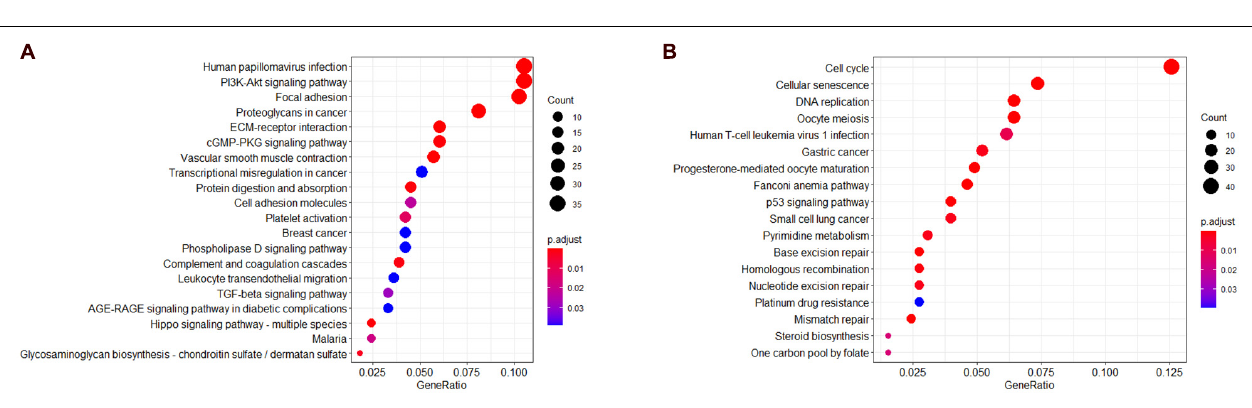
FIGURE 5 | Kyoto Encyclopedia of Genes and Genomes (KEGG) pathway analysis. (A) KEGG pathway of genes in the yellow modules. (B) KEGG pathway of genes in the green